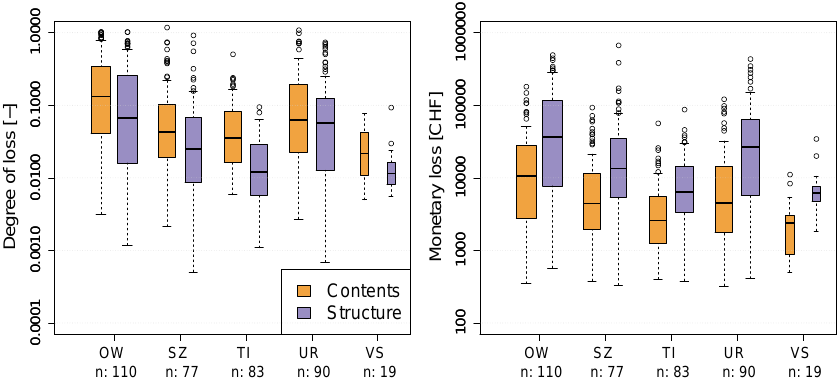
Figure 1. Canton-wise distribution of records in the data sets used for the analyses. ( Left ): Degree of loss [-], ( right ): monetary loss [CHF]; both on log-scale. Sample size is given by “n:” and illustrated by the width of the box plots. Due to the low number of claim records, data recorded in Geneva and Appenzell Inner-Rhodes are not presented.